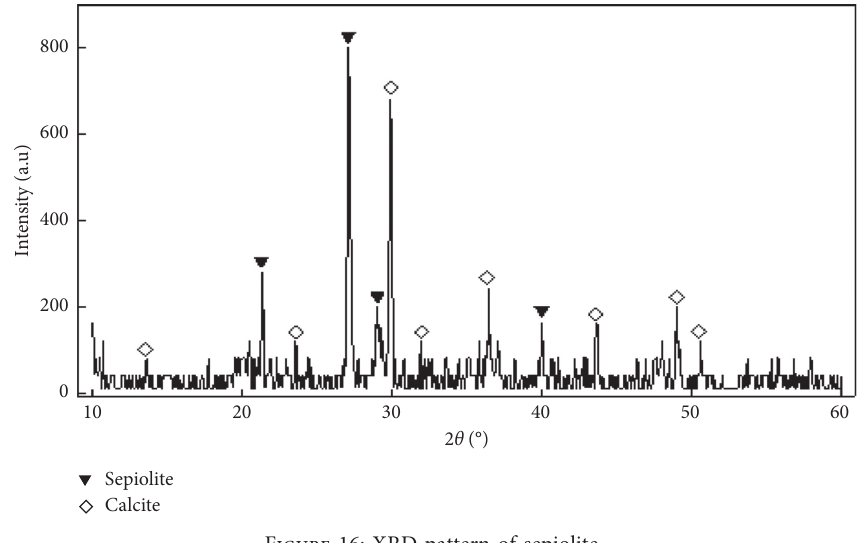
Figure 16: XRD pattern of sepiolite.